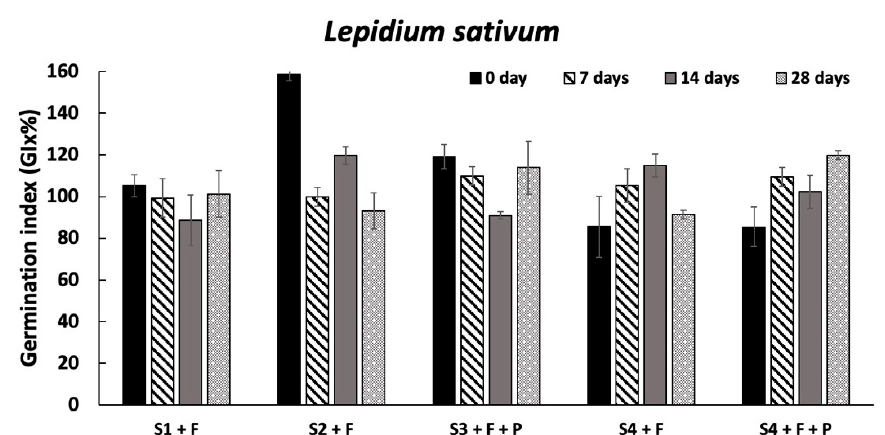
Figure 2. Germination index of Lepidium sativum seeds (GIx%) exposed to elutriates from conditioned soils (S1 + F, S2 + F, S3 + F + P, S4 + F, S4 + F + P) at different experimental times (0, 7, 14 and 28 days). The bars represent the standard errors.